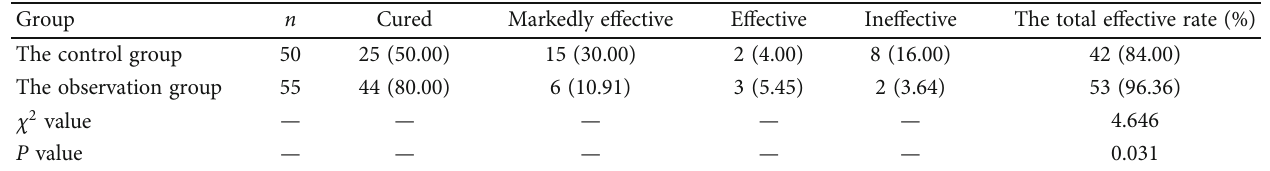
Table 2: Clinical e ffi cacy on the two groups [ n ,